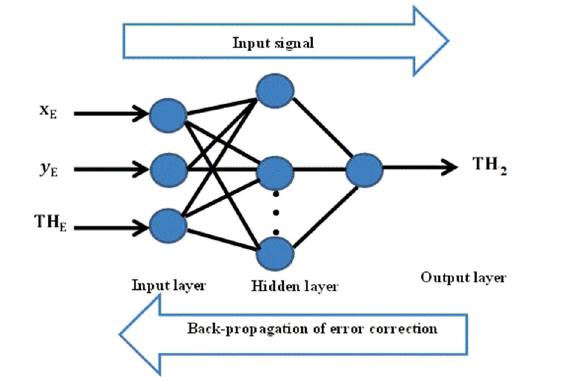
Fig. 2. Simulation results of three joints for three- link robot workspace.